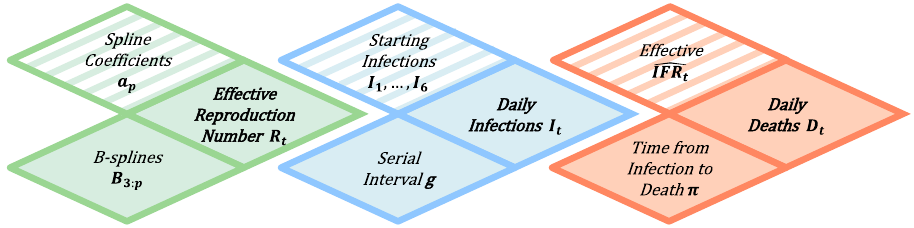
Figure 1. Schematic overview of the adapted Bayesian hierarchical model (cf. Flaxman et al. 11